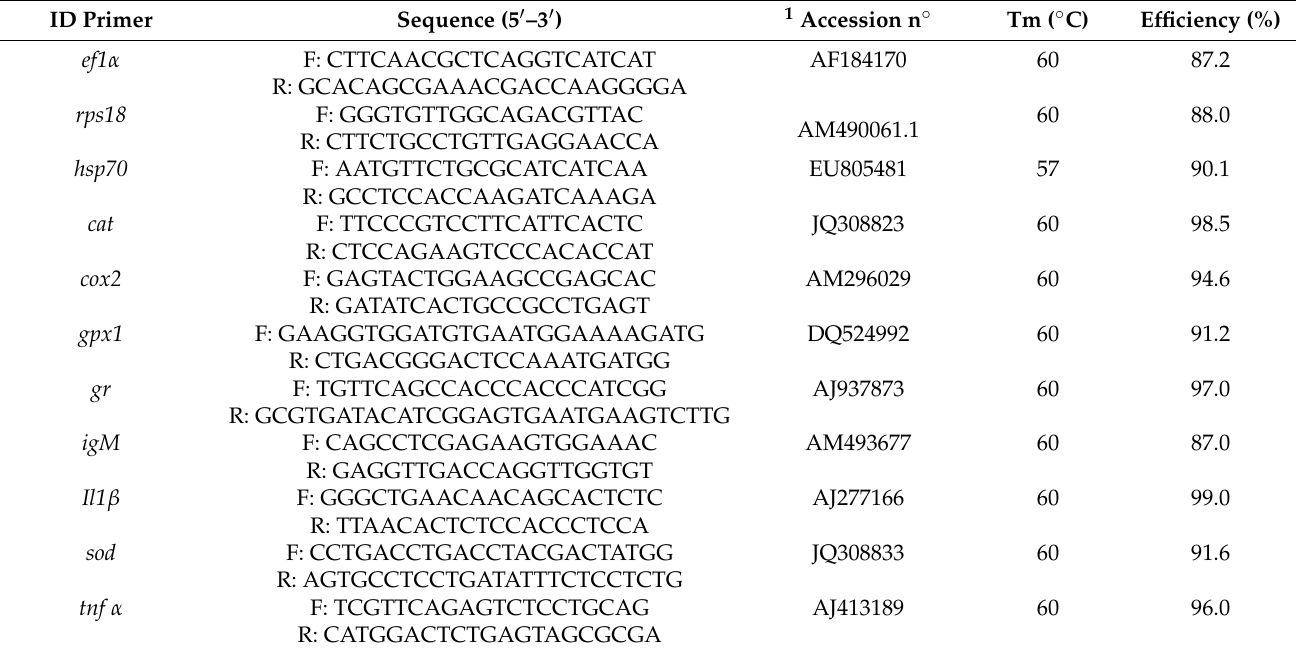
Table 1. Genes and primers used for